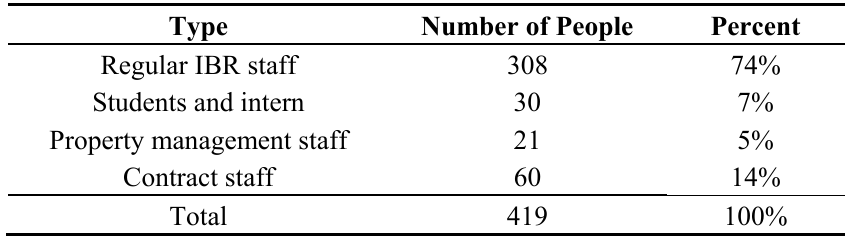
Table 6. Occupant data by staff type.